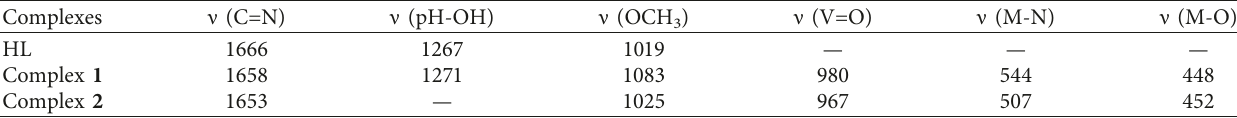
Table 2: Important infrared frequencies